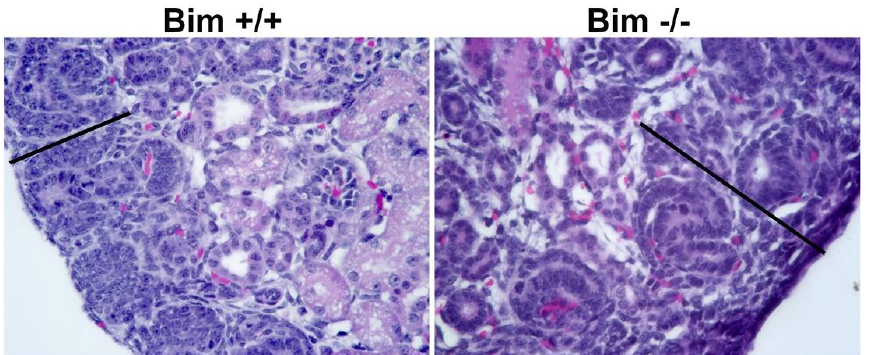
Figure 3. Increased nephrogenic zone depth Bim −/− mice. Nephrogenic zone depth was calculated by measuring six nephrogenic zone areas (note line) on the periphery of each kidney from P0 Bim +/+ and Bim −/− mice and is summarized in Table 1. Data representative of six mice. Magnification is 400×.